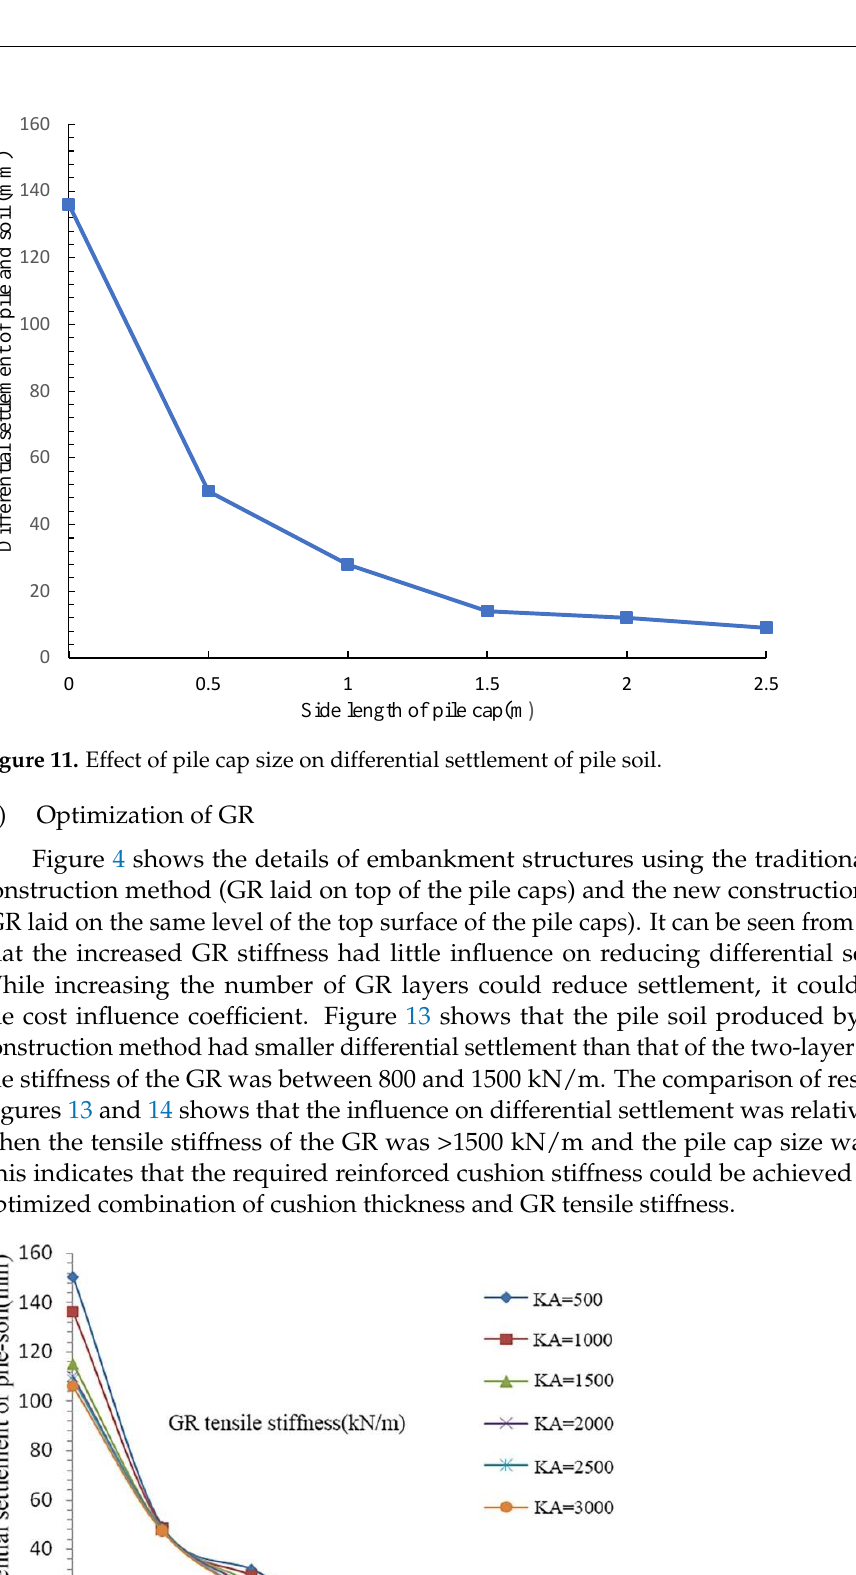
Figure 13. Differential settlement of pile soil with different GR tensile stiffness values and numbers of layers of corresponding GR.